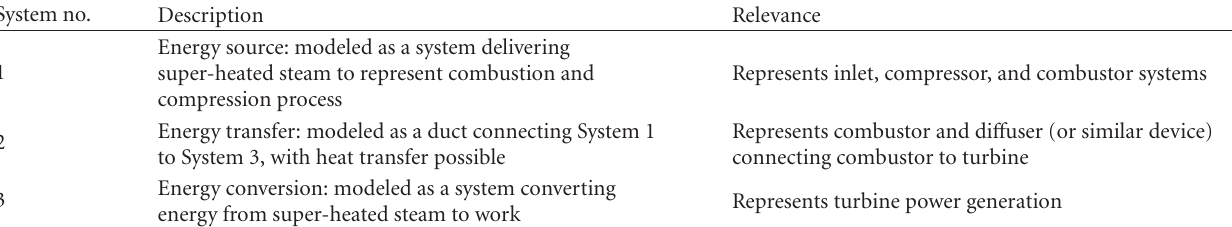
Figure 1: Sketch of complex turbojet-based engine outlining focus areas for simplified analysis. (System 1: Combustor as energy source, System 2: Duct as energy transfer, System 3: Turbine as energy conversion.). Source: http://commons.wikimedia.org/wiki/File:Jet engine. svg Table 1: Description of simplified internal flow systems.